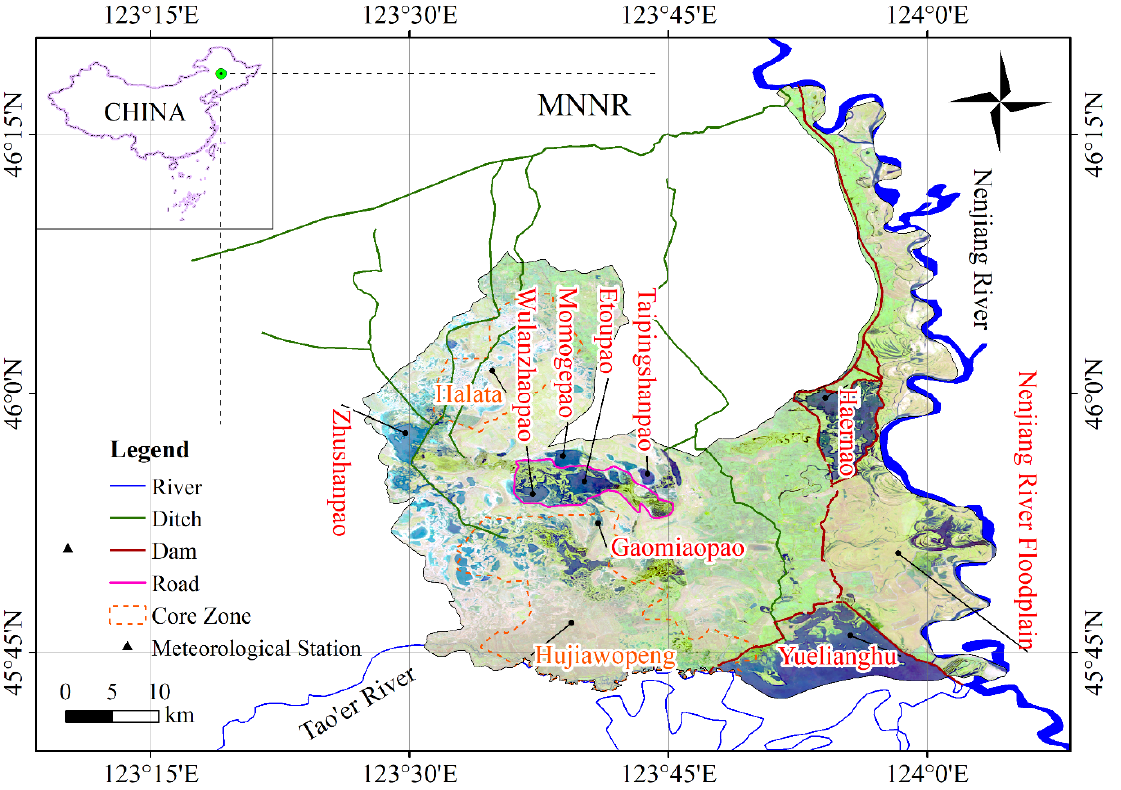
Figure 1. Location of the 1440 km 2 Momoge National Nature Reserve (MNNR), China, and the network of lakes, rivers, and artificial ditches within the reserve. Data source: The United States Geological Survey (USGS) Landsat data.